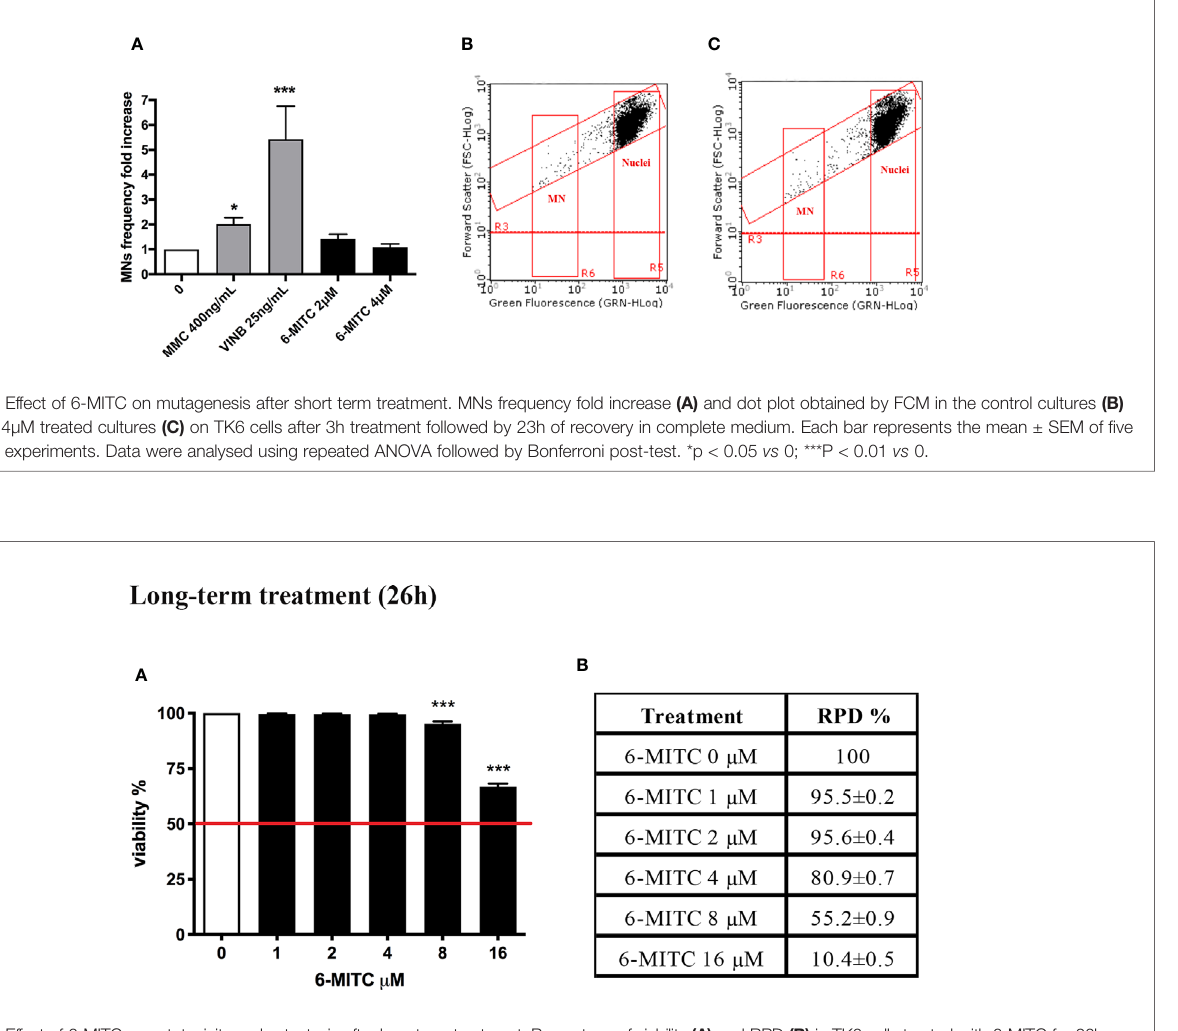
FIGURE 5 | Effect of 6-MITC on cytotocicity and cytostasis after long term treatment. Percentage of viability (A) and RPD (B) in TK6 cells treated with 6-MITC for 26h. Each bar represents the mean ± SEM of fi ve independent experiments. Data were analysed using repeated ANOVA followed by Dunnet post-test. *** p < 0.001 vs 0.